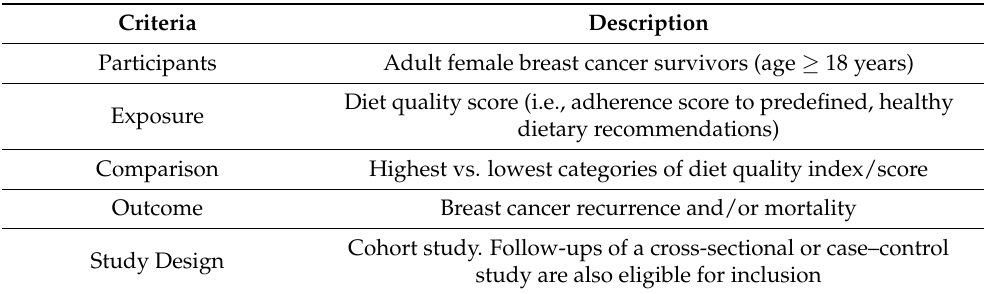
Table 1. Criteria for inclusion and exclusion of